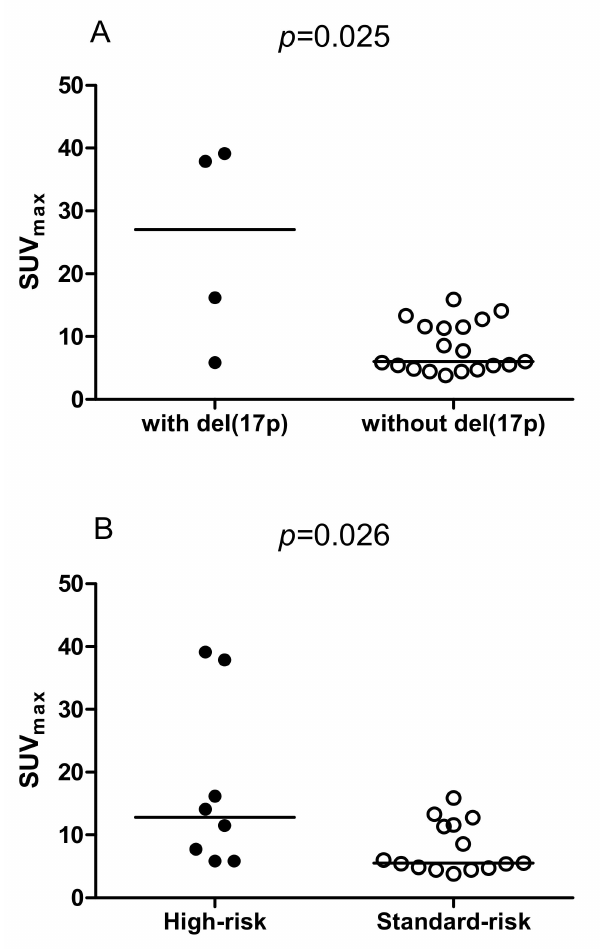
Figure 2. Link between cytogenetics and maximum standardized uptake value (SUV max ): ( A ) Patients with del(17p) ( n = 4) showed a significantly higher SUV max compared with those without del(17p) ( n = 19) ( p = 0.025). ( B ) High-risk cytogenetics, i.e., t(4;14), t(14;16), and del(17p) ( n = 8) indicated a significantly higher SUV max when compared with standard-risk cytogenetics ( n = 15) ( p =